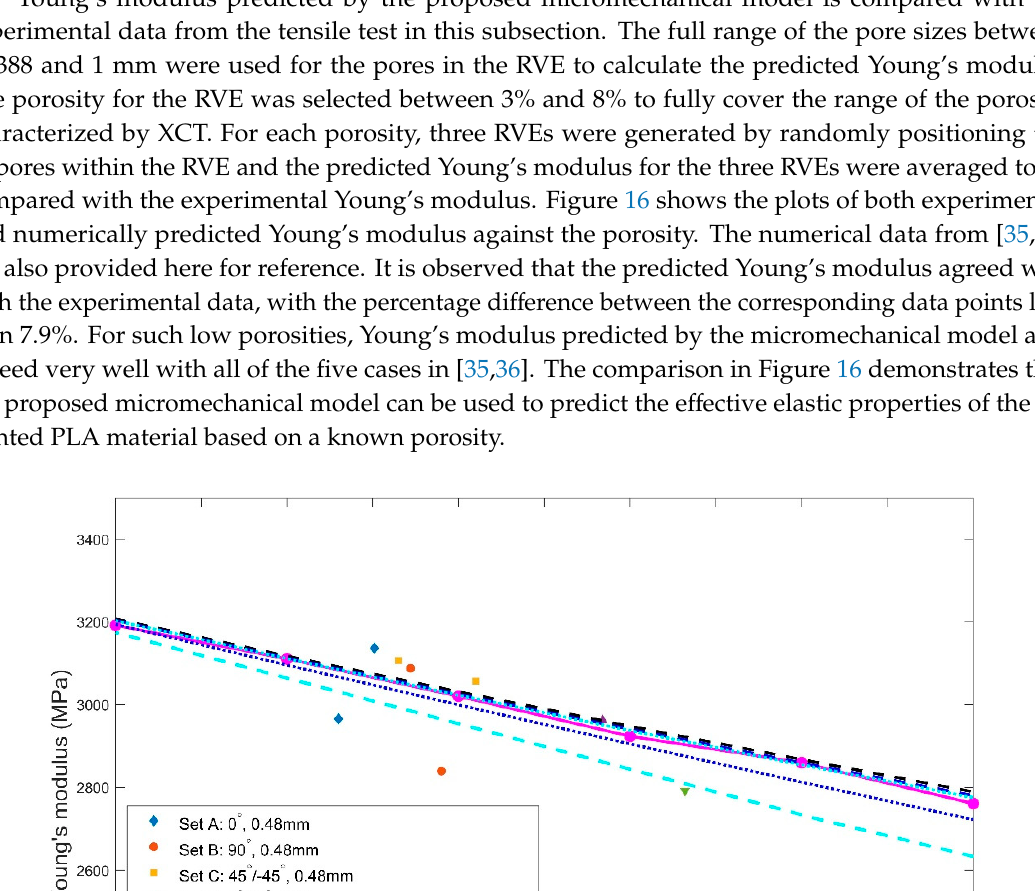
Figure 15. Predicted Young’s modulus against the porosity for the RVEs using pore size distributions within [0.388 mm, 0.2 mm] and [0.388 mm, 1 mm].